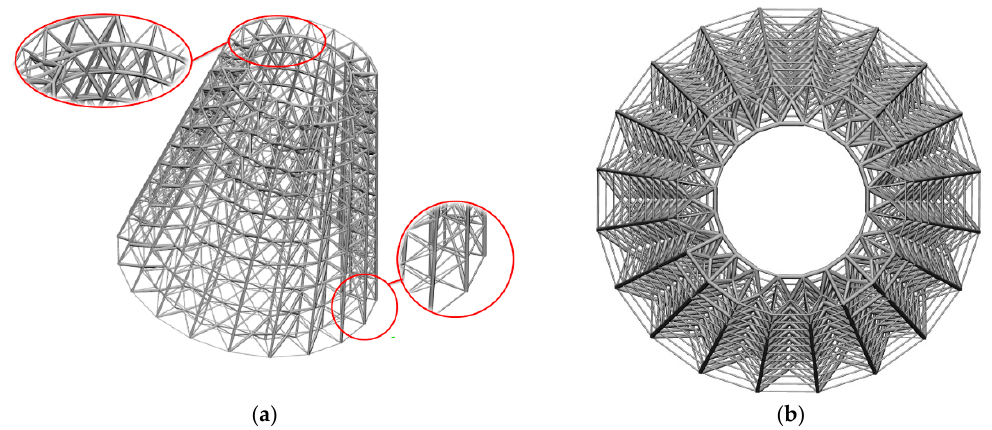
Figure 17. Final optimized structure of the hollow round platform: ( a ) three-dimensional stereogram; and ( b ) vertical view.